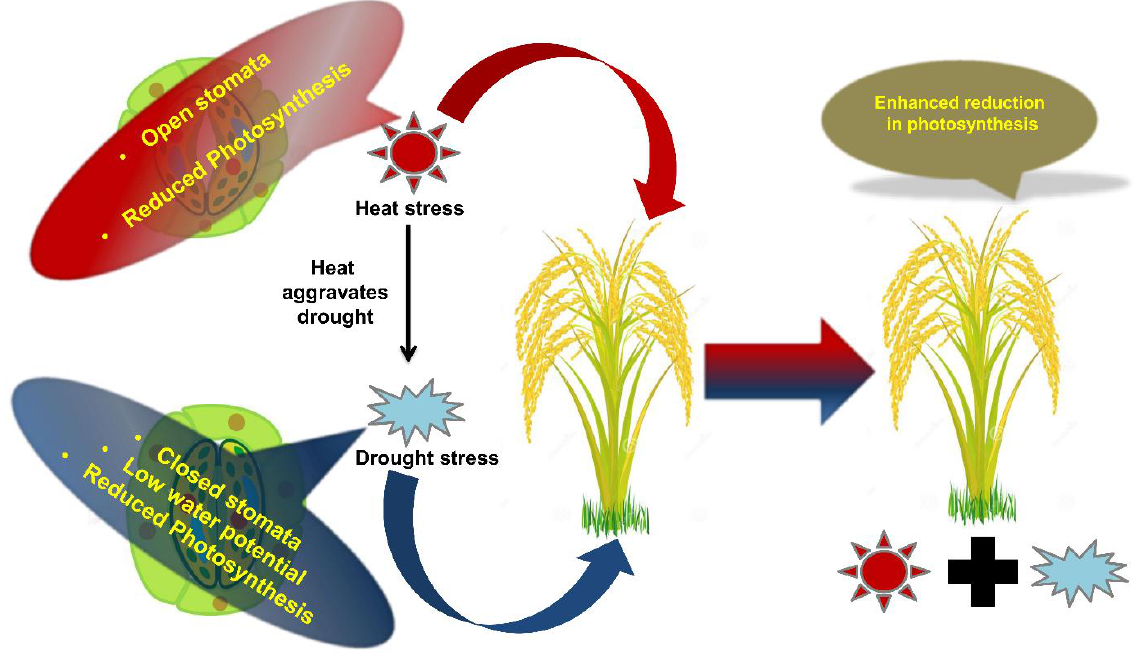
Figure 2. Schematic representation showing the effects of combined stress on plants. Effect of combined stresses on plants is explained taking an example of heat and drought. For example, simultaneous exposure to heat and drought leads to enhanced retardation of physiological processes such as photosynthesis.